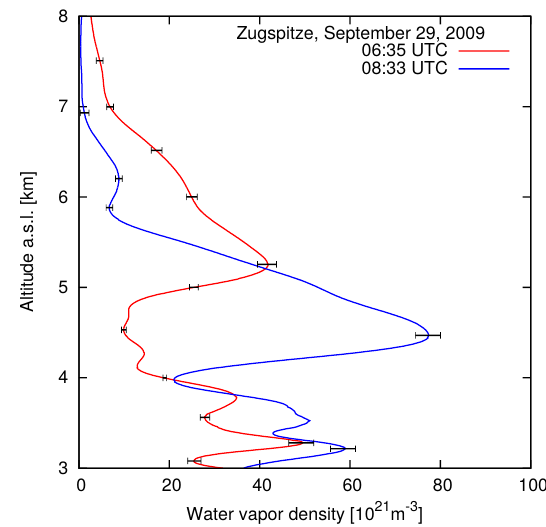
Figure 11. Example of extreme variability of the vertical distribu- tion of water vapor under rather humid conditions. Due to a wind speed of about 16ms − 1 at an altitude of 4.5km (data from ra- diosonde Munich at 12:00UTC, 100km to the north) a time shift of 2h corresponds to a horizontal shift of about 115km at this alti- tude. The two profiles were recorded within less than 2h. The ex- ample error bars ( ± 2 σ ) represent statistical uncertainties caused by electronic noise in the